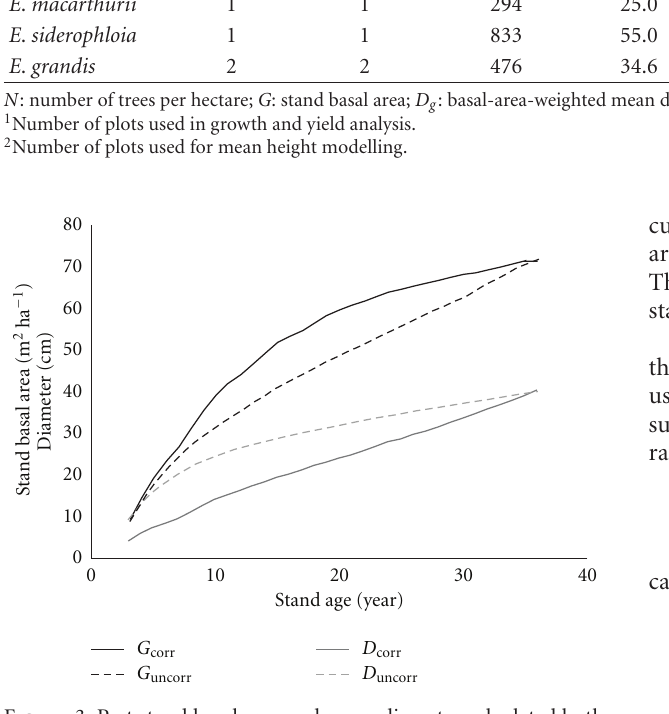
Figure 3: Past stand basal area and mean diameter calculated both with ( G corr , D corr ) and without ( G uncorr and D uncorr ) considering the e ff ect of mortality. G corr and D corr include trees which were dead in the measurement of 2009 but were living at earlier stages of stand